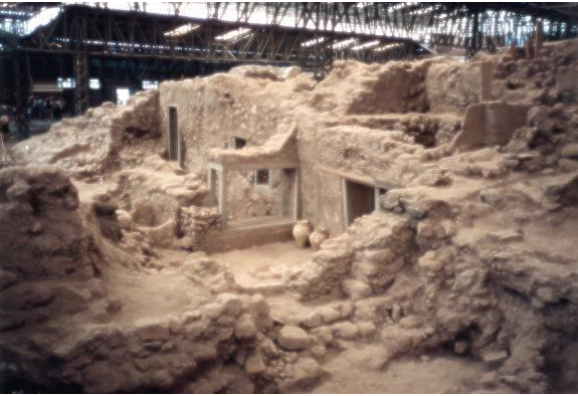
Figure 6. Akrotiri on Thera, view of the